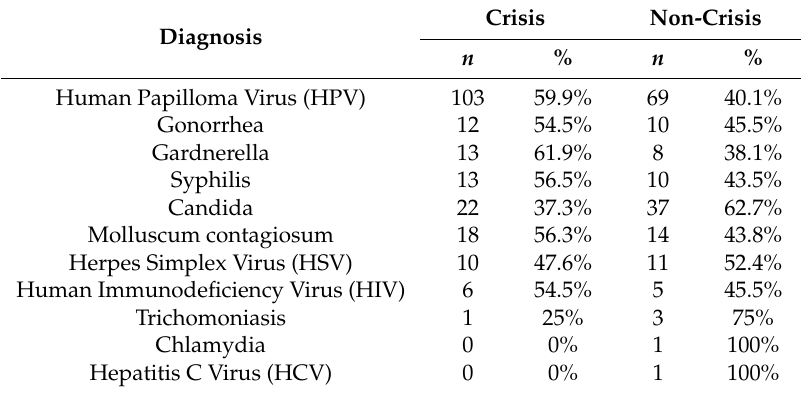
Figure 1. Prevalence of STI diagnosis during the study period. Table 5. STI Comparison between the Crisis Period vs. Non-Crisis Periods.